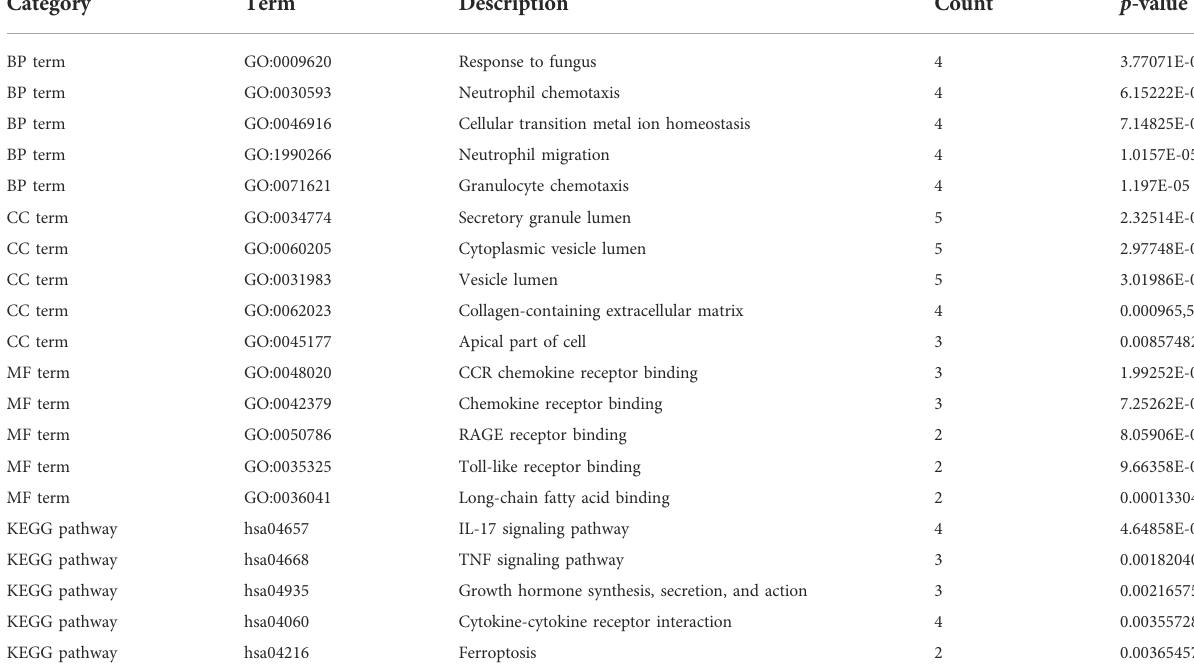
TABLE 2 Screening of human and mouse common DEGs in SCM by comprehensive microarray analysis. DEGs Gene names Upregulated Downregulated DEGs, differentially expressed genes; SCM, sepsis cardiomyopathy.